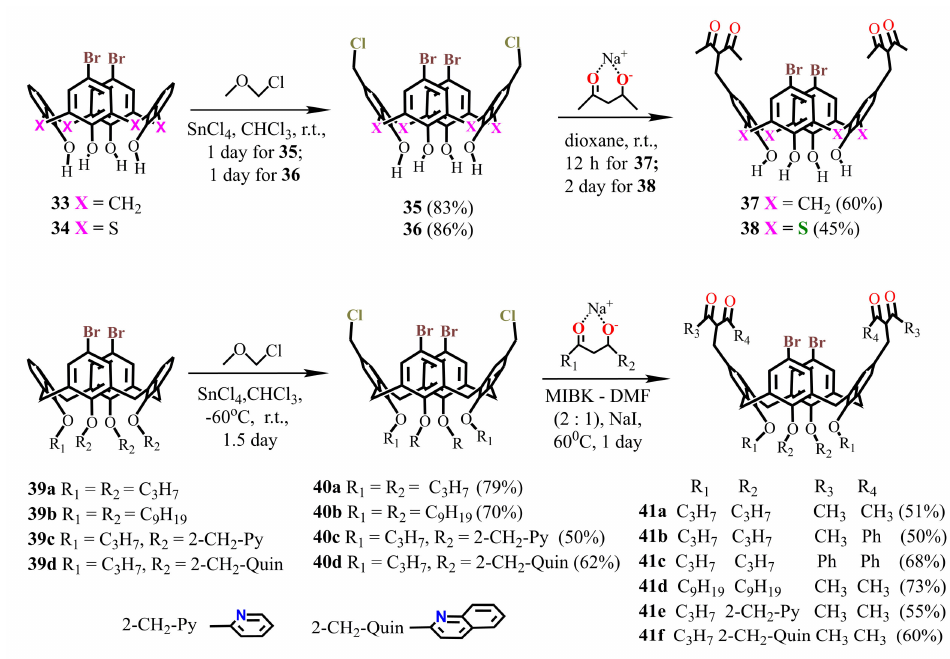
Scheme 10. Synthesis of dibromo-bis-1,3-diketone derivatives of calix[4]arene 37 , 41 and thia- calix[4]arene 38